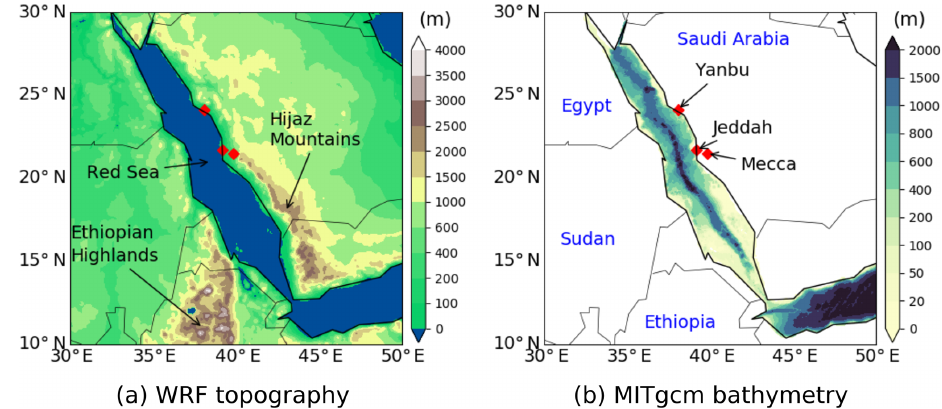
Figure 3. The WRF topography and MITgcm bathymetry in the simulations. Three major cities near the eastern shore of the Red Sea are highlighted. The Hijaz Mountains and Ethiopian Highlands are also highlighted. Table 1. The initial conditions, boundary conditions, and forcing terms used in the